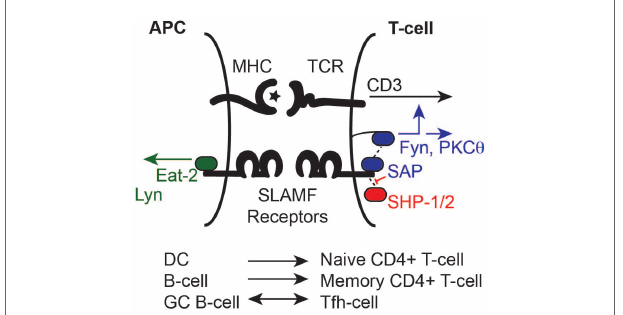
FiGURe 3 | Slamf receptors modulate the cellular communication between antigen-presenting cells (APCs) and T cells. Binding of SLAM family members to their ligands induces the phosphorylation of their cytoplasmic tails and the subsequent binding of SLAM-associated protein (SAP) or EAT2 through a tyrosine-containing motif (ITSM). SAP is widely expressed by T cells and EAT2 is expressed by APCs. These two molecules can recruit and activate several Src kinases (including Fyn) that modulate cell activation by signals generated through the T cell receptor (TCR) and costimulatory proteins, such as CD28. Signals mediated by the SLAM receptors can also affect the function of APCs. SLAM receptors recruit various SH2-domain-containing proteins giving rise to different signals that determine distinct and, in some cases, divergent biological outcomes.